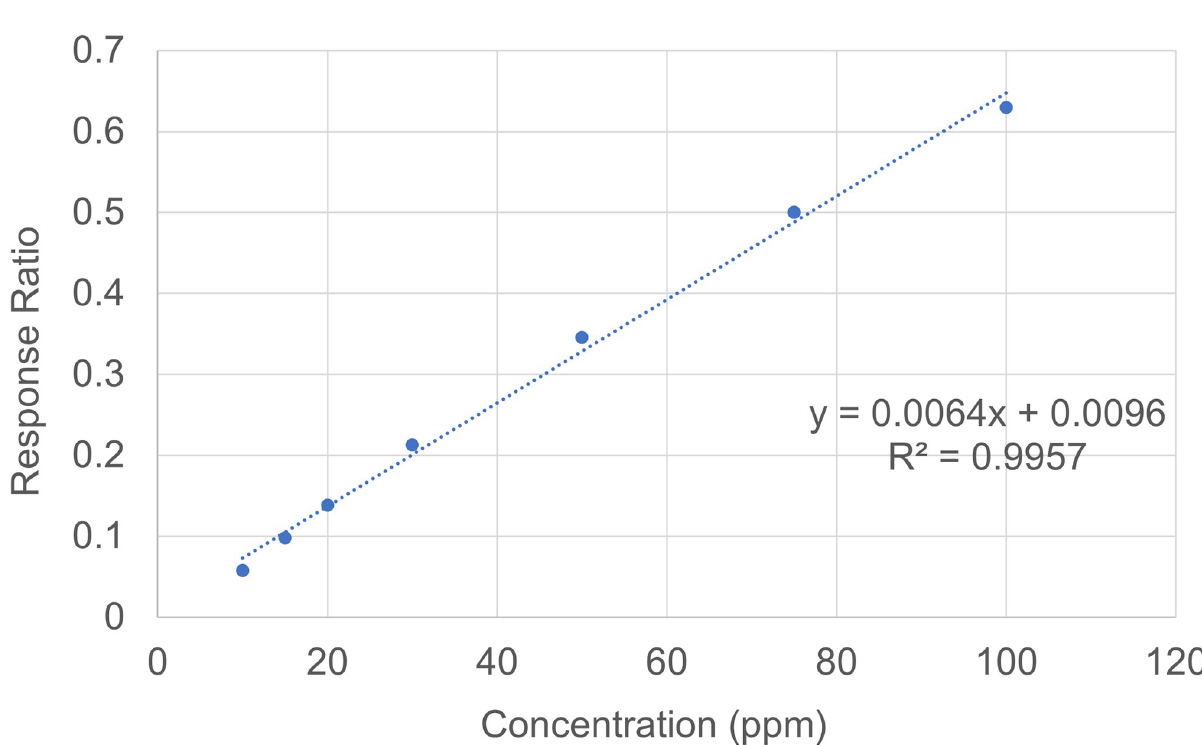
Fig 4. A representative standard curve. The y-axis plots the response ratio between the internal standard and the analyte.